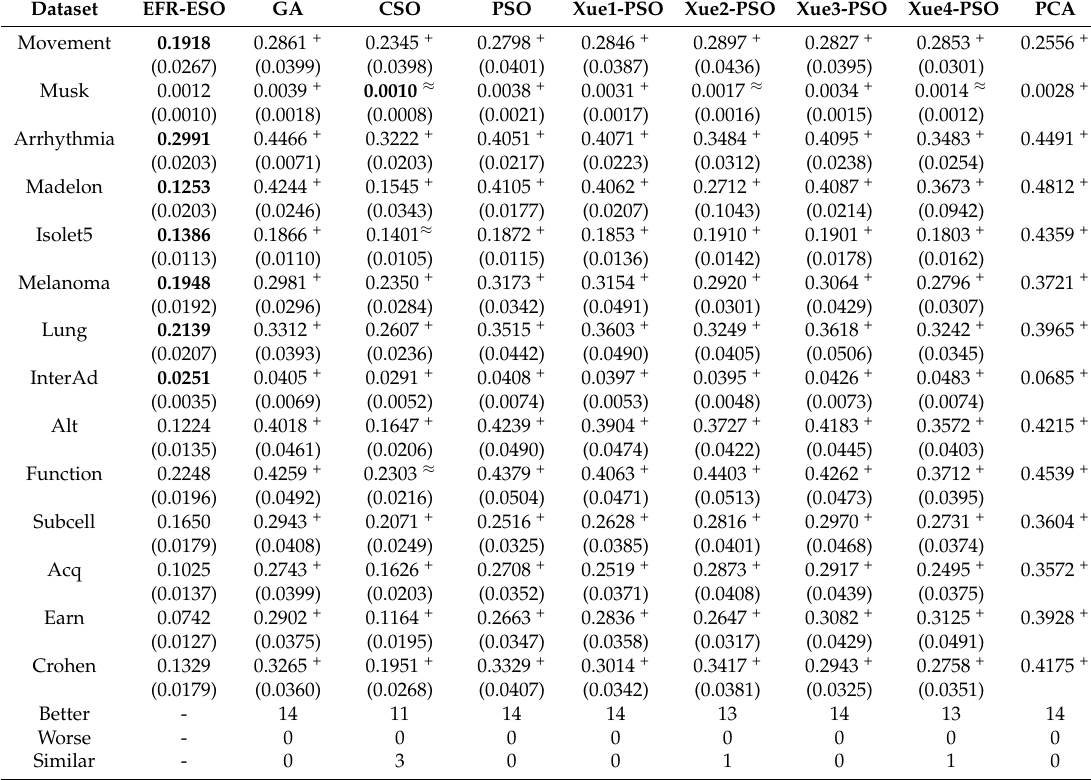
Table 2. Average error